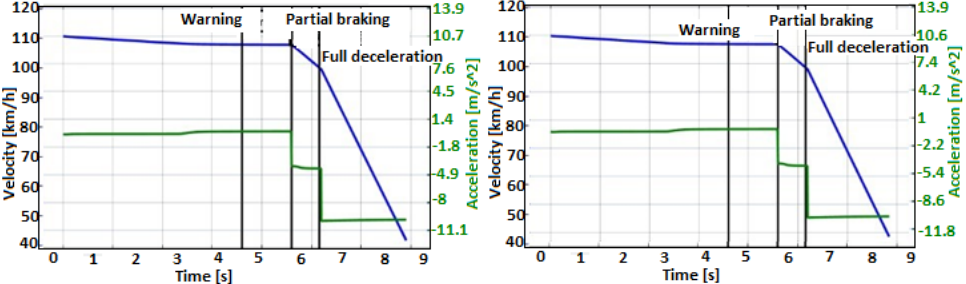
Figure 13. Speed profile of ego-vehicle. TTC = 1.1 and TTC = 2.1.